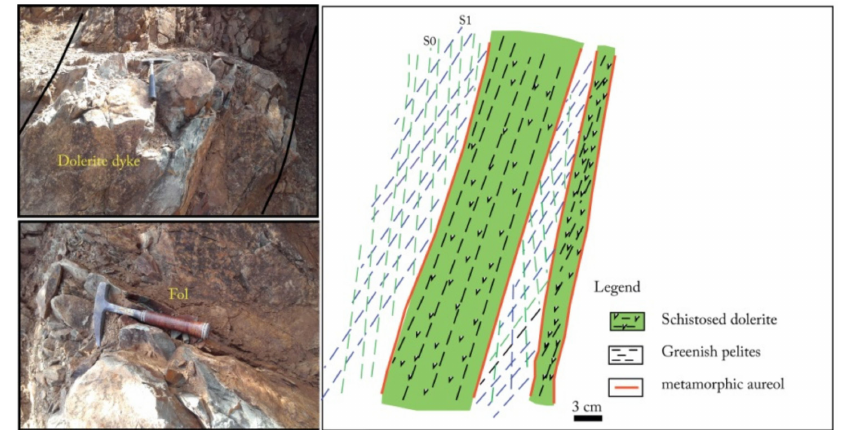
Figure 8. Foliation (Fol) in outcropping dolerites.